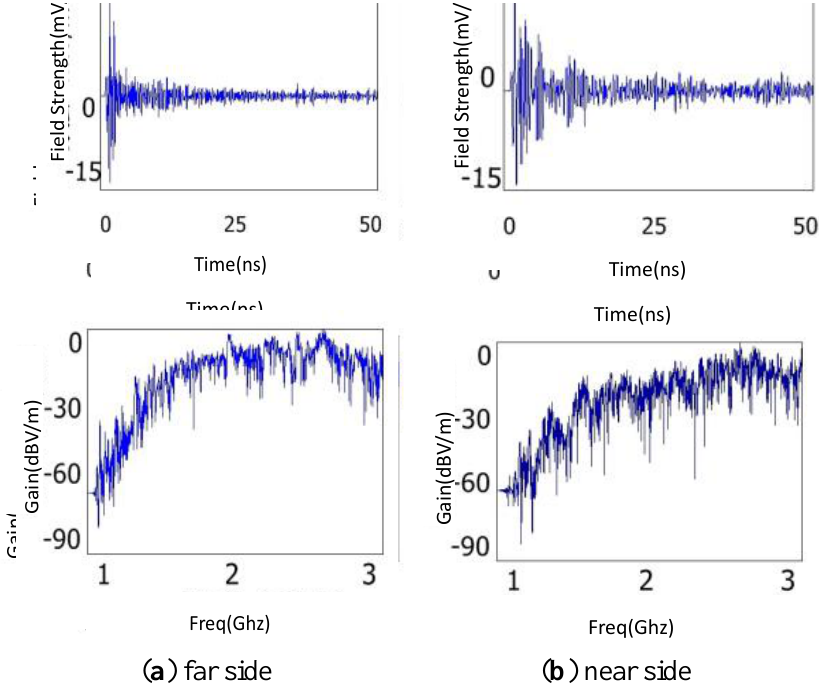
Figure 12. Simulation results of the influence of CB on the propagation of EM waves.